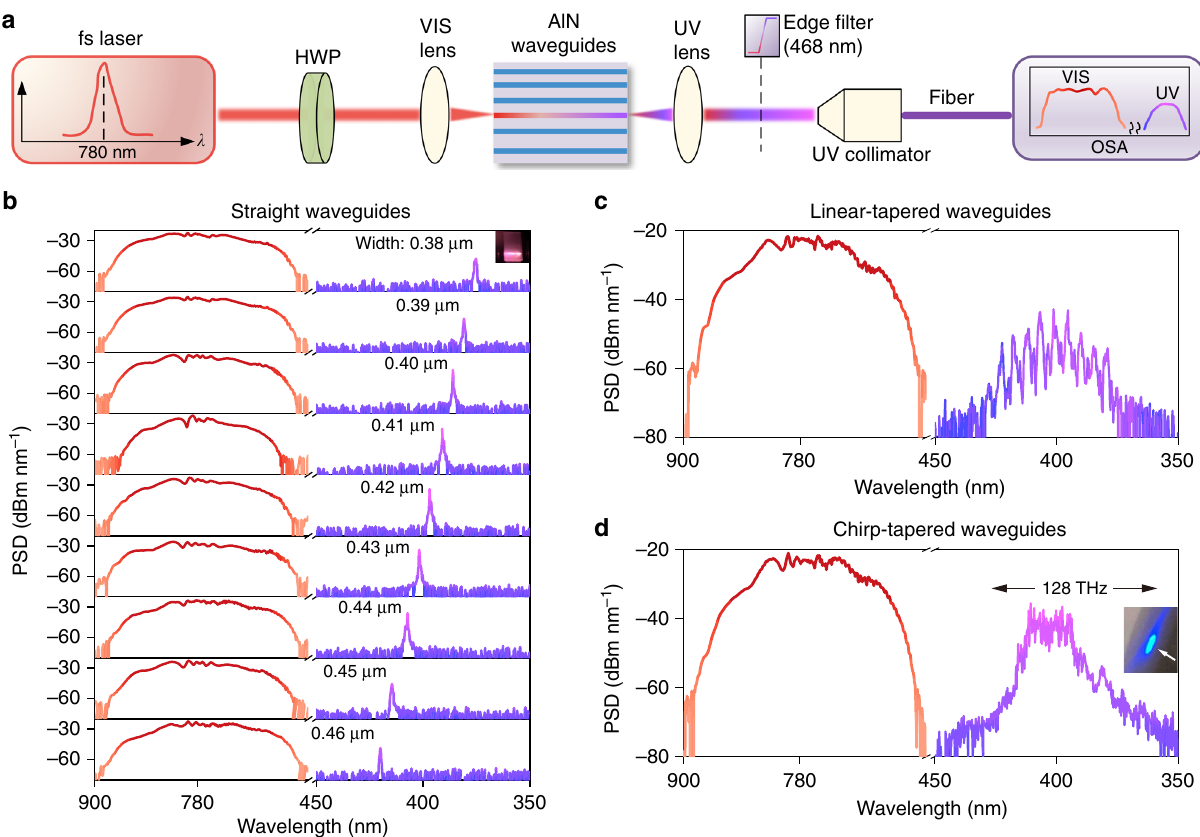
Fig. 2 Phase-matched ultraviolet microcombs. a Sketch of the experimental setup. fs: femtosecond, HWP: half-wave plate, OSA: optical spectrum analyzer. To capture UV light, a short-pass edge fi lter is introduced to block concomitant near-VIS light (see Methods). b Near-VIS (red) and shifted UV (purple) spectra recorded from a set of straight AlN waveguides with varied widths (0.38 – 0.46 μ m). Inset: a photograph of a glowing AlN chip upon UV light generation. c and d Near-VIS and UV Spectra respectively recorded from linear- and chirp-tapered AlN waveguides (tapering widths: 0.5 – 0.3 μ m). The observable UV spectral span in ( d ) is ~128 THz. Inset of ( d ): a bright blue fl uorescence image of collimated outgoing UV light (orientation denoted by a white arrow) on a piece of white paper. In ( b – d ), the on-chip pump pulse energy is ~237 pJ ( P ave of 19 mW), and the wavelength resolution of the OSA is set to be 0.1 nm. The distinct noise fl oors of near-VIS and UV spectra arise from different monochromator modes